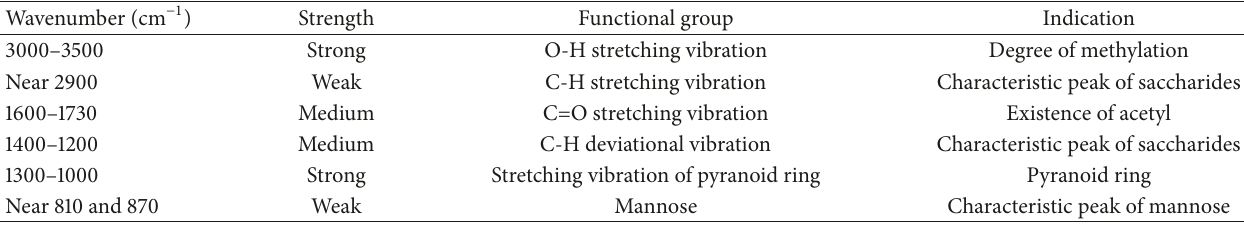
Table 1: FTIR spectrum of